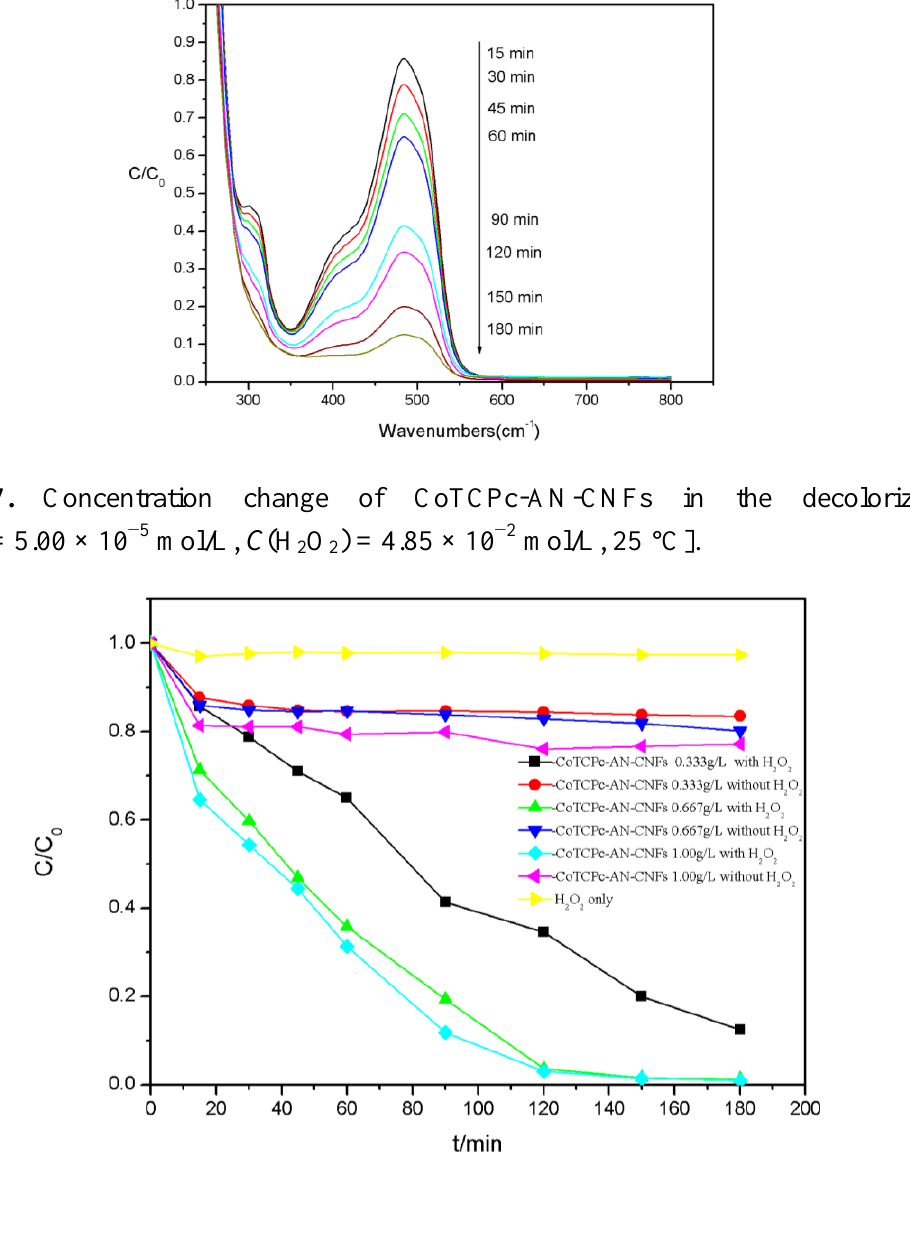
Figure 6. UV-vis spectra changes with reaction time [ C (AO7) = 5 × 10 −5 mol/L, C (CoTCPcNa-AN-CNFs) = 0.333 g/L, C (H